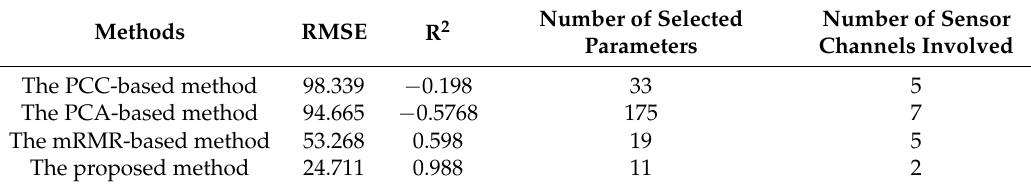
Figure 19. Predicted tool wear values of several methods with the C6 testing set. Table 5. Several performance indexes of three methods on the testing set.